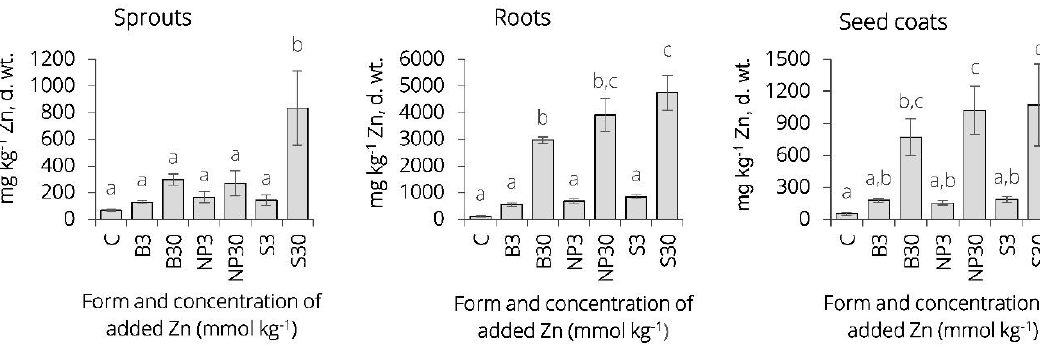
Table 1. The average length of the longest sprout and root of barley ( Hordeum vulgare L.) plants, and the average fresh weight and dry weight of sprout biomass after 10-days cultivation. The data represent absolute and relative mean values ± SD of three independent measurements with seven plants each. Zinc was applied in three different forms (bulk,